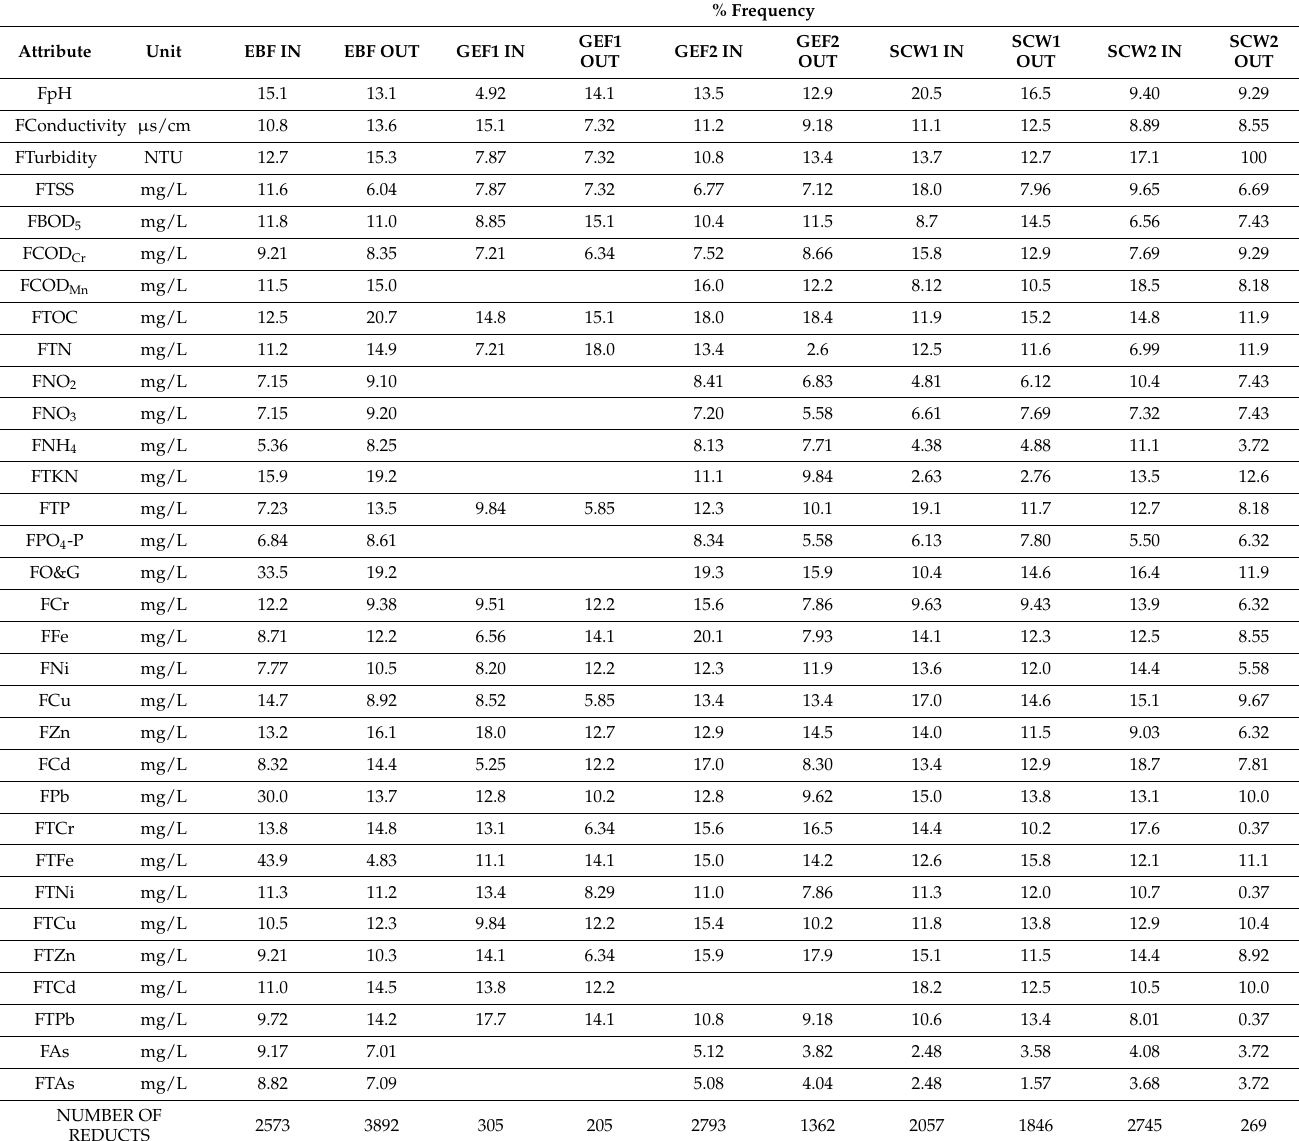
Table 5. Discernibility matrix of five bioretentions for both IN and